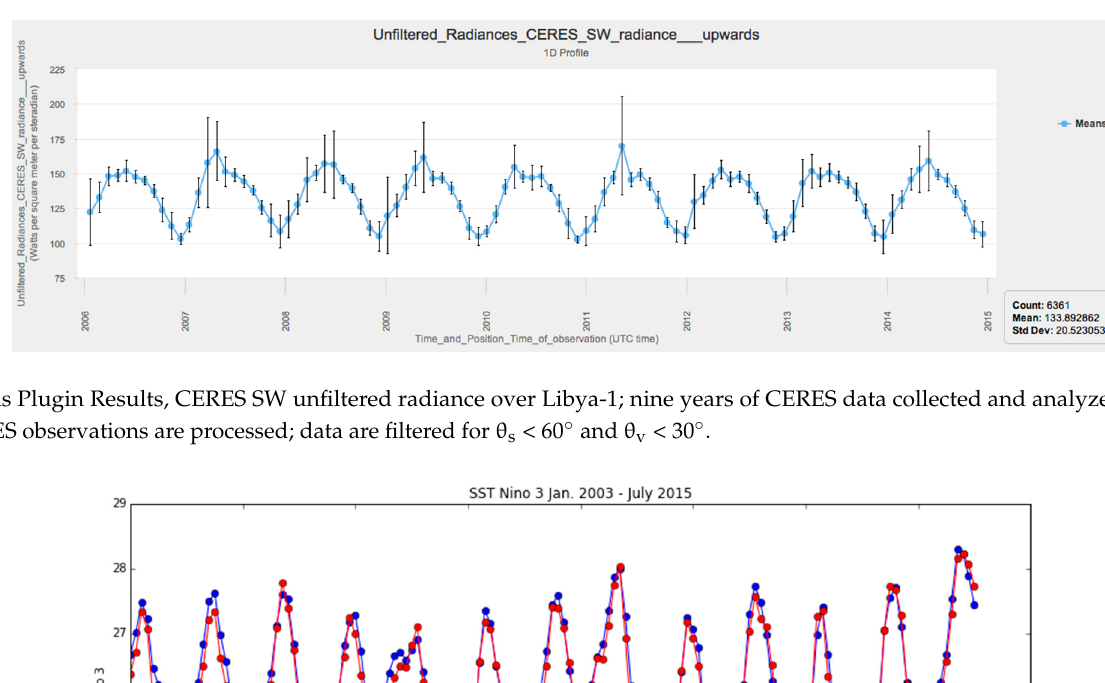
Figure 10. MIIC Analysis Plugin Results, CERES SW unfiltered radiance over Libya-1; nine years of